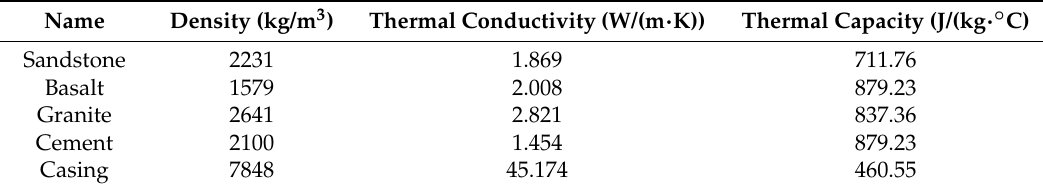
Table 3. Thermodynamics properties of the materials and formation.